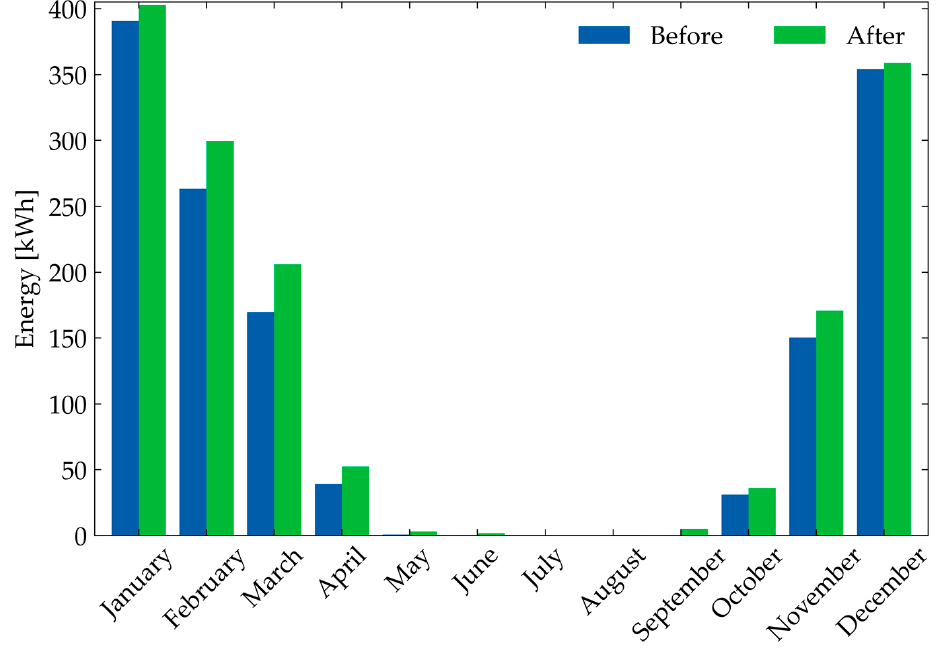
Figure 13. Heating energy load provided to the Greek site room before and after the Figure 13. Η eating energy load provided to the Greek site room before and after the renovation.